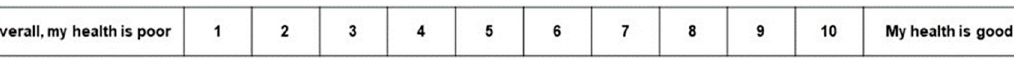
Figure 1. An example of the layout of the questionnaire.